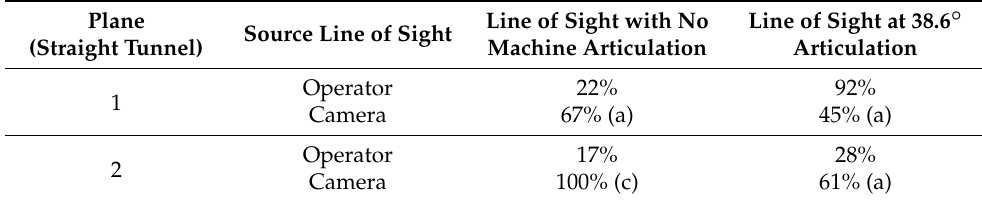
Figure 5. Straight ( left ) and articulated ( right ) LHD in a straight drift with the operator’s line of sight (light shading) on planes 1 and 2. Table 1. LOS for operator and camera with and without machine articulation in a straight tunnel. Camera responsible for best view listed in parentheses.